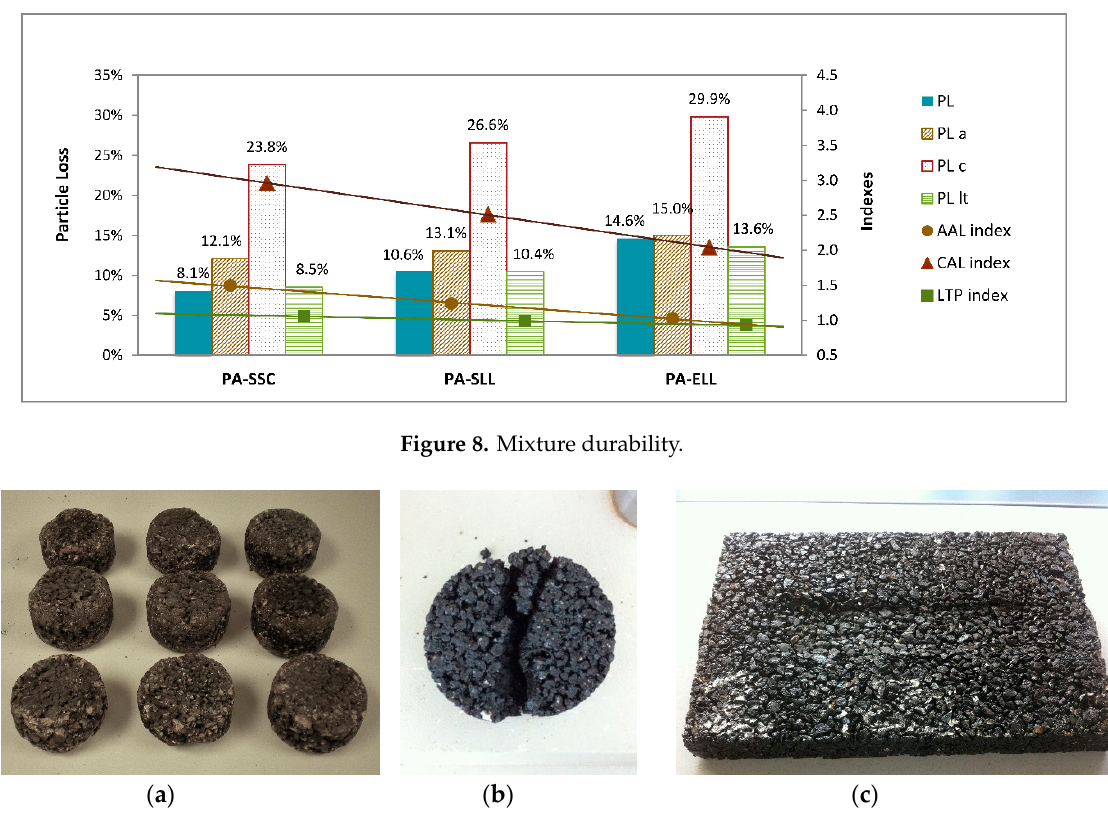
Figure 9. ( a ) Samples after the durability tests; ( b ) specimen after the moisture susceptibility test; ( c ) slab sample after the wheel tracking